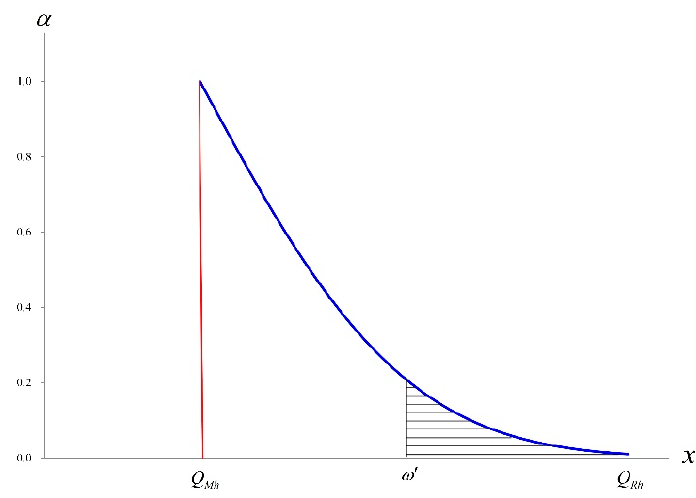
η ( x ) and vertical line x = ω (cid:48) x η and vertical line ′= x ω . Figure 1. Diagram corresponding to h h